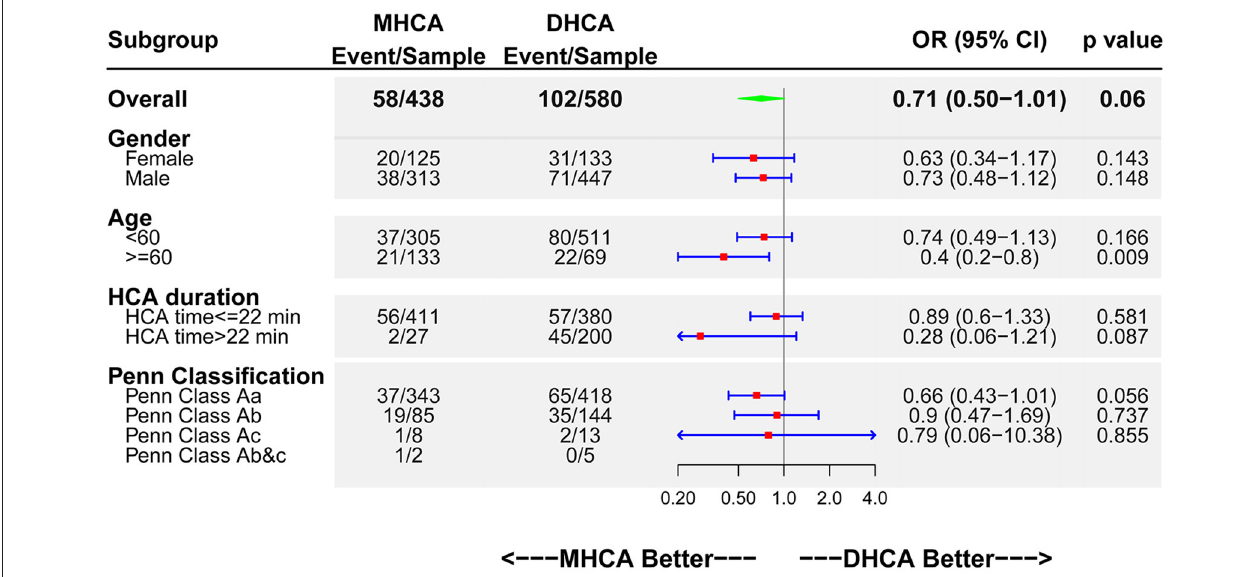
FIGURE 2 | Forest plot of MHCA vs. DHCA regarding CMO by subgroups. DHCA, deep hypothermic cardiac arrest; MHCA, moderate hypothermic cardiac arrest; CMO, composite major outcomes; HCA, hypothermic cardiac arrest; OR, odds ratio; CI, confidence interval.